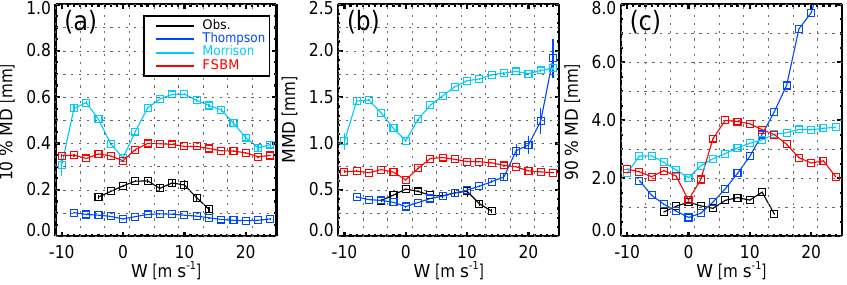
Figure 9. Average percentile mass diameters as a function of w bins (2ms − 1 bin widths) for temperatures between − 32 and − 40 ◦ C: 10% MDs are shown in (a) , MMDs in (b) , and 90% MDs in (c) with observations in black, Thompson in dark blue, Morrison in cyan, and FSBM in red. Vertical bars extending from each box represent standard errors; however, note that standard errors are rather small due to relatively large sample sizes.